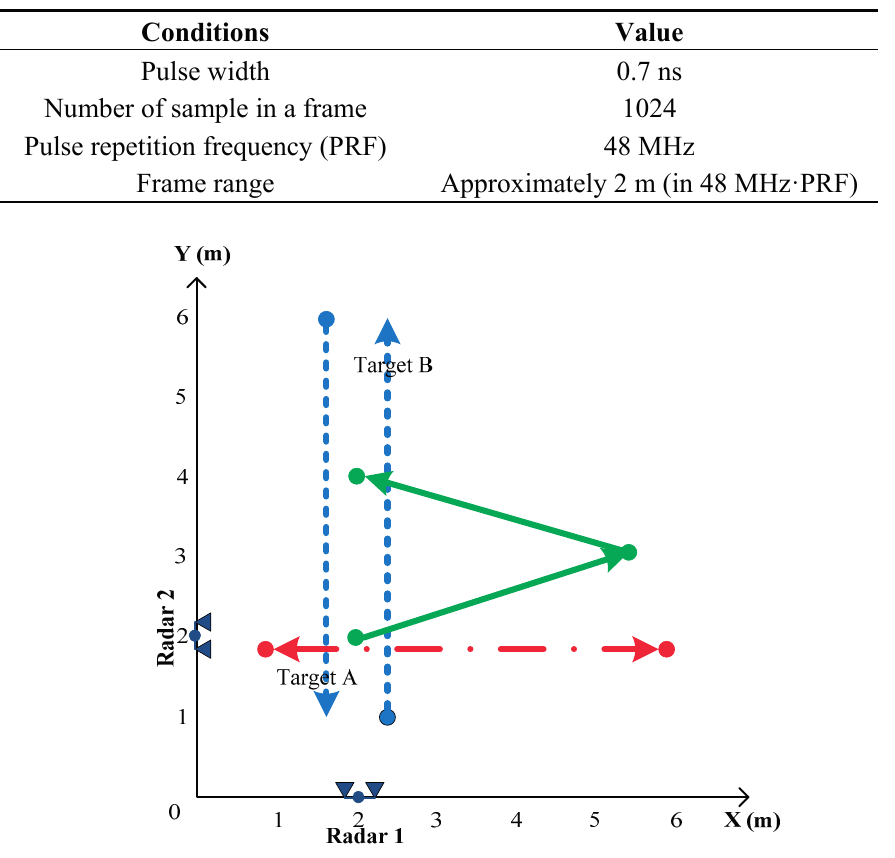
Table 1. Operation conditions of the experimental impulse radio ultra-wide band (IR-UWB) radar.